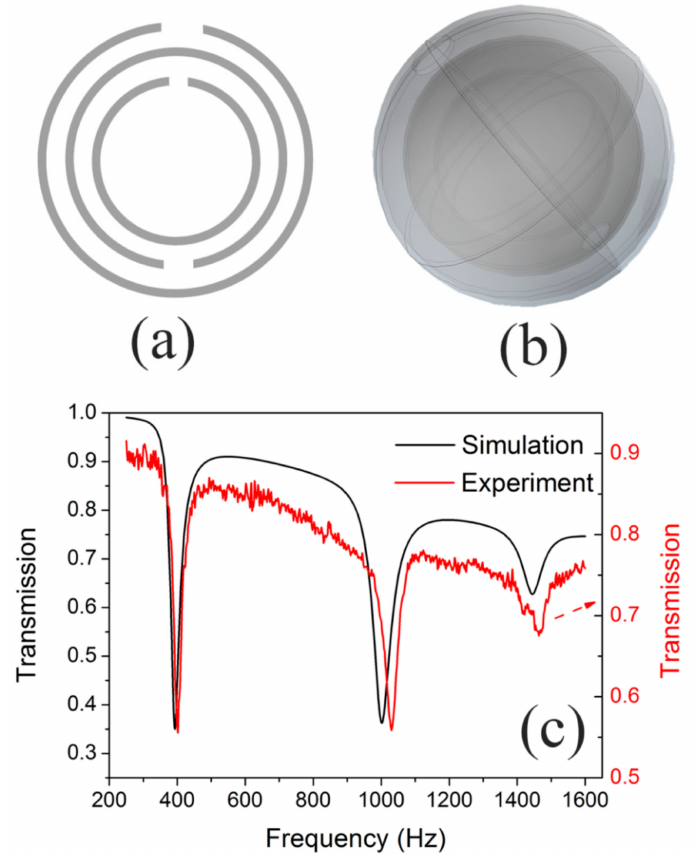
Figure 9. ( a ) the 2D and ( b ) 3D schematic diagram of TNSHS structure, ( c ) the transmission results of the